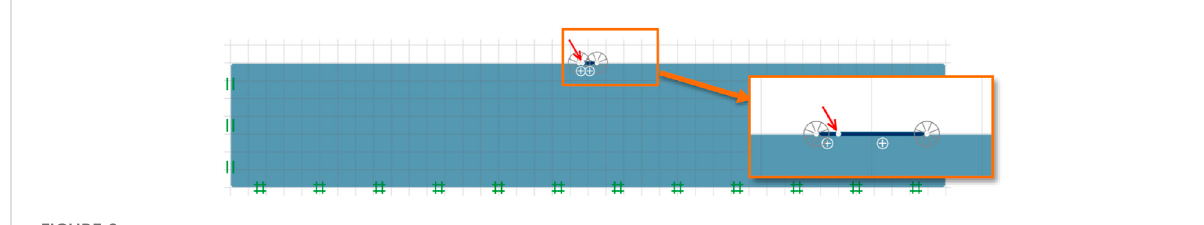
FIGURE 2 Numerical model used for FELA analysis of bearing on the rock with β = 60 ° and e/B =